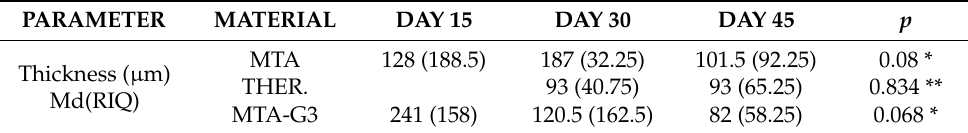
Table 8. MTA, Theracal and MTA-G3 fibrous capsule thickness. Differences between periods. PARAMETER